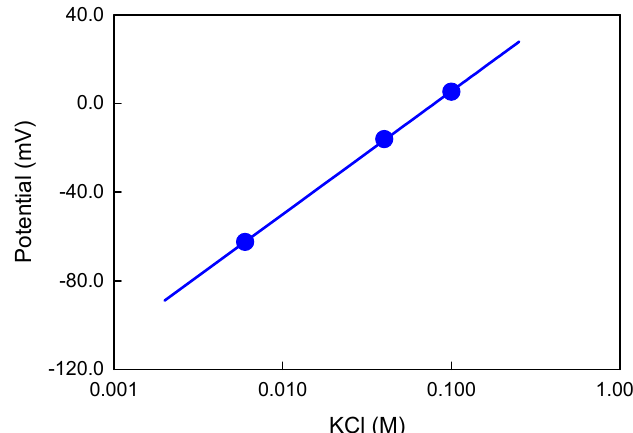
Figure 4. Potential response of a potassium-selective electrode having a plasticized PVC membrane containing potassium ionophore I was measured versu s the solid-contact reference electrode and plotted as a function of KCl concentration. The solid line is a fit through the data with a slope of 56 mV per